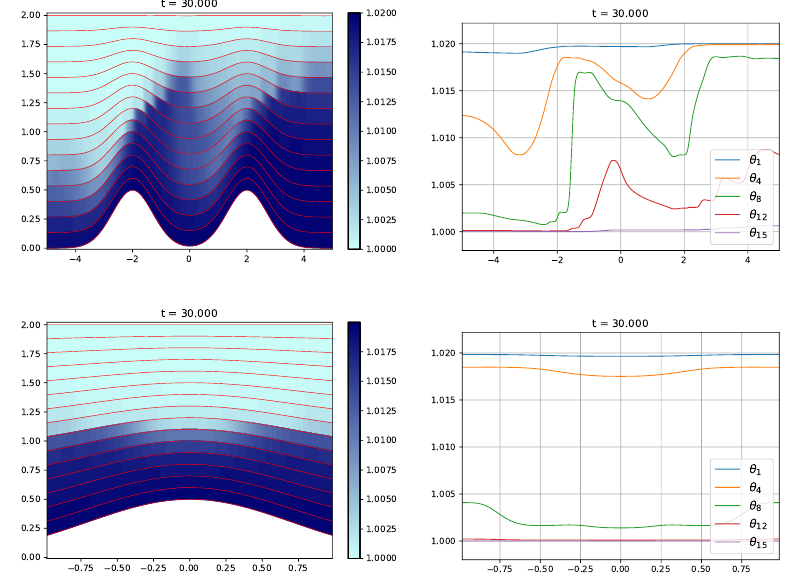
Figure 36. Distribution of θ for a cut in the plane y = 0 (upper row) and x = − 2 (lower row).